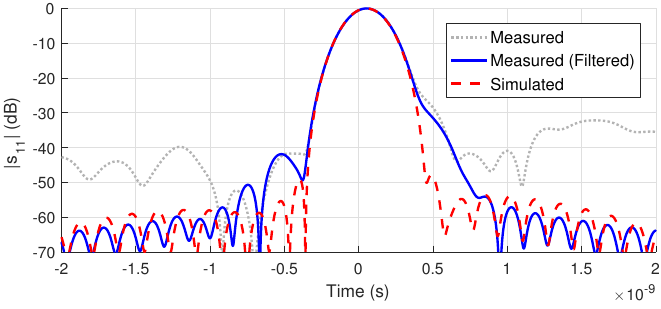
Figure 8. | s 11 ( t ) | of the PMMA (simulated and measured).